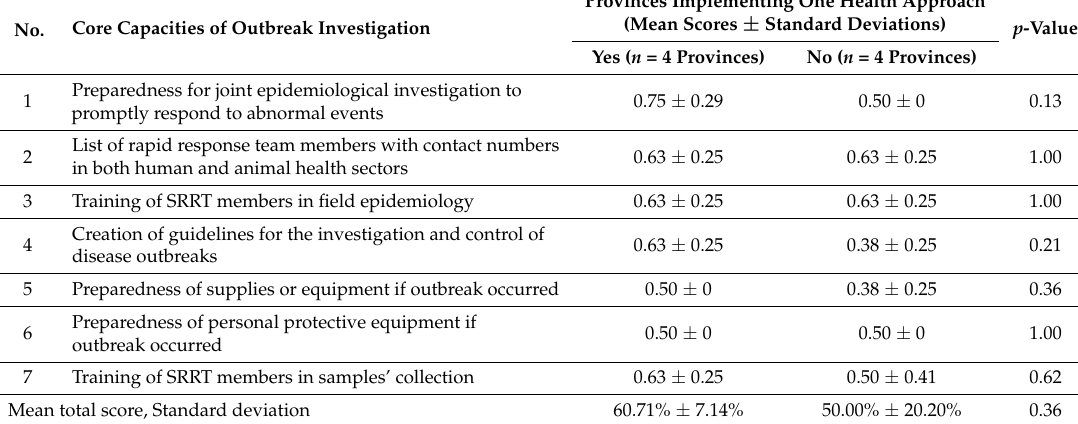
Table 4. Assessment of outbreak investigation capacities between the provinces implementing One Health approach and the provinces did not implement One Health approach in Thailand,